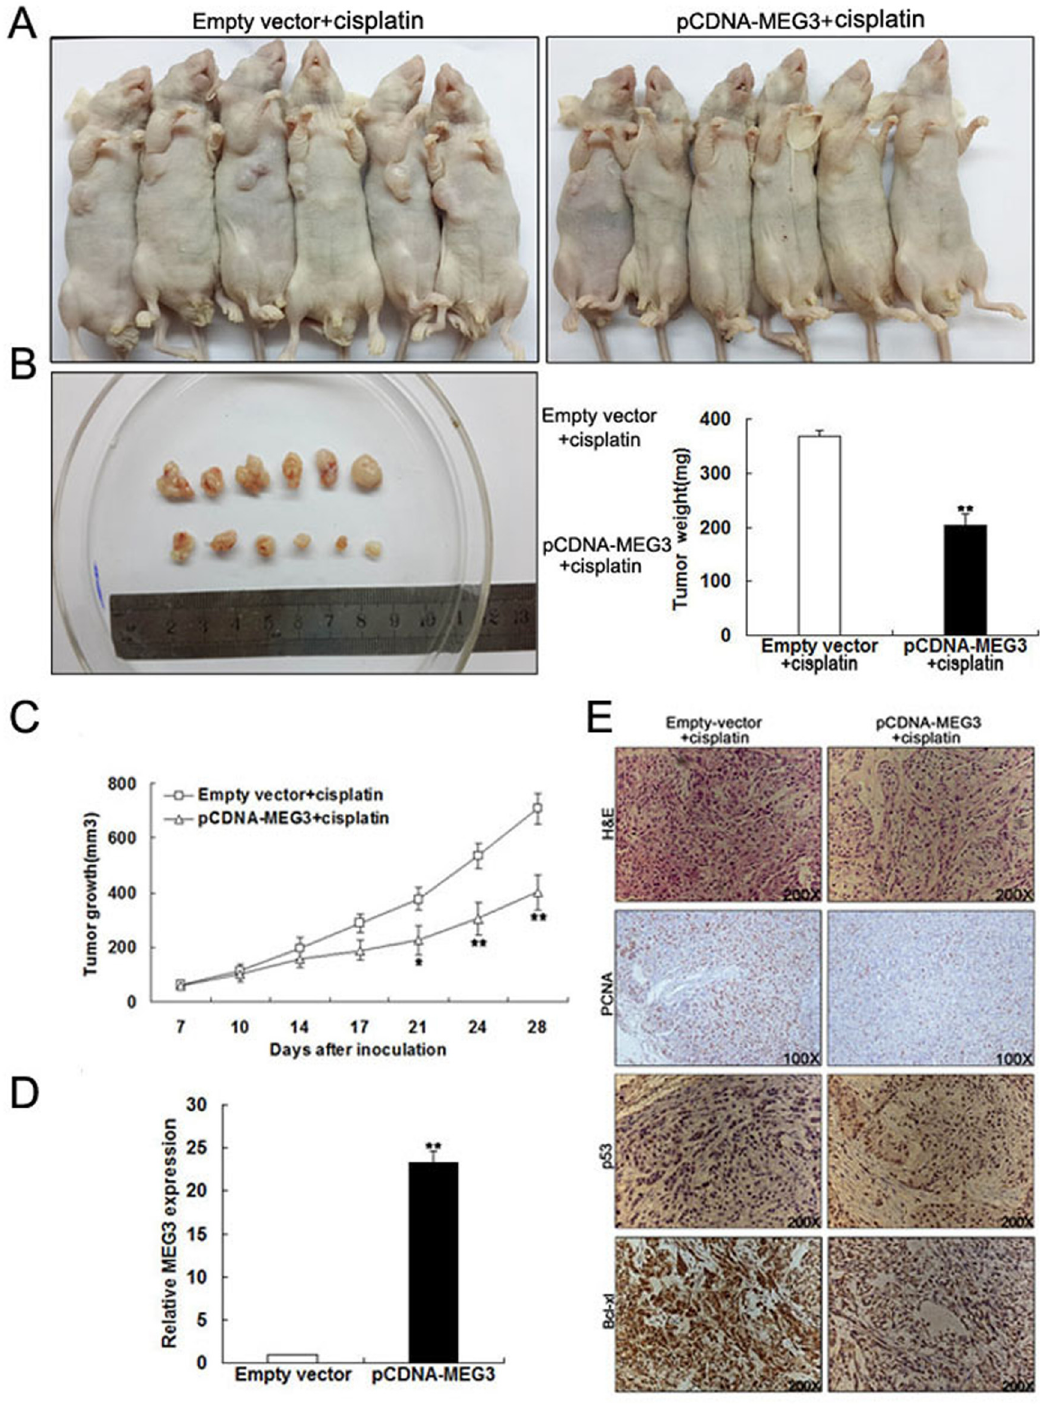
Fig 7. MEG3 improves the in vivo sensitivity of A549/DDP cells to cisplatin. (Fig 7A, 7B) Four weeks after initial cisplatin administration, the tumor volume and average weight of mice receiving pCDNA- MEG3 - or empty vector-transfected A549/DDP cells were recorded. (Fig 7C) Tumor volume was calculated twice weekly after cisplatin treatment. (Fig 7D) qRT-PCR analysis of MEG3 expression levels in tumor tissues formed from pCDNA- MEG3 - or empty vector-transfected A549/DDP cells. (Fig 7E) Tumors developed from pCDNA- MEG3 -transfected A549/DDP cells showed lower PCNA protein levels, higher p53 protein expression, and lower Bcl-xl protein expression than those developed from control cells. Upper: H&E staining; second, third row and lower: immunostaining. Original magnification, ×100 or ×200. * P < 0.05, ** P < 0.01.